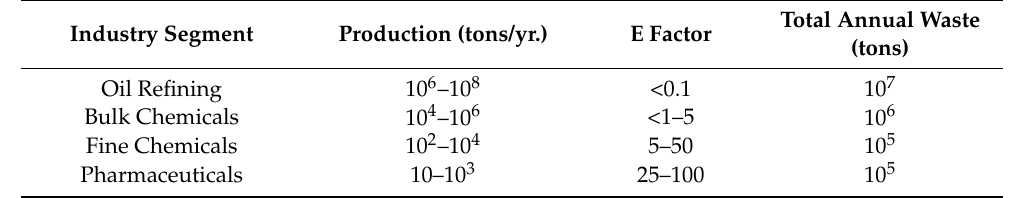
Table 1. E factors, the ratio of the mass of waste to the mass of product, for various chemical industries. The ideal E factor is zero (zero waste); a higher E factor indicates more waste and an increased negative environmental impact